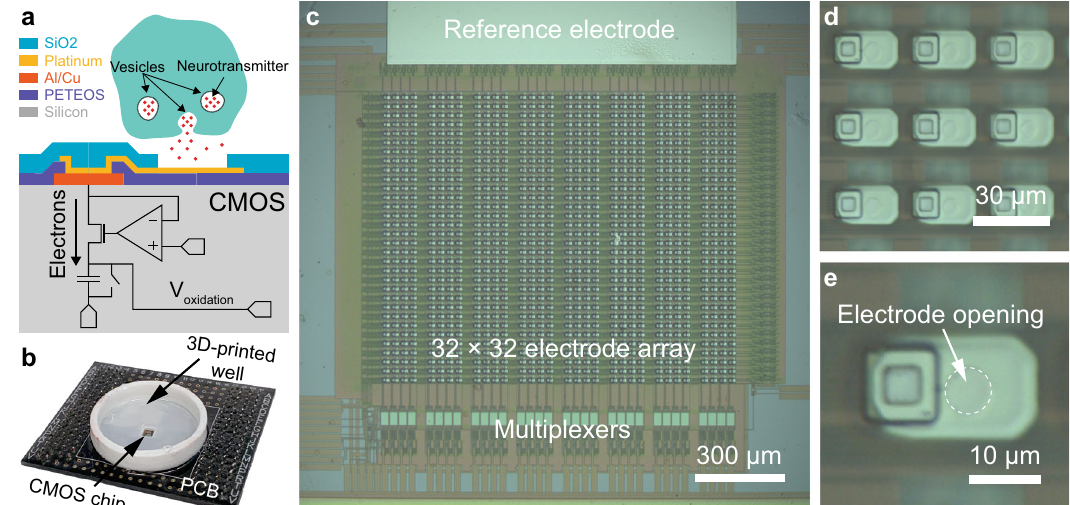
Fig. 1 CMOS-based electrochemical detector array for high-throughput quantal analysis. a Neurotransmitters released from cells diffuse onto an electrode and undergo a redox reaction. The oxidation releases electrons into the electrode and results in electrical current at the ampli fi er, which allows a buildup of electrons onto one side of a capacitor, creating a current-dependent output, V oxidation . The output of the ampli fi er is readout periodically and the capacitor is reset using a switch to begin the next detection period. b The device is bonded onto a PCB to interface the CMOS device to external electronics. The fi nal packaging of the device includes a well that permits the addition of electrolytic solutions to the top of the electrode array for electrochemical experiments. c The CMOS-based electrochemical device contains an array of 32 × 32 electrode array wherein each electrode is connected to its own dedicated ampli fi er and a reference electrode is integrated on-chip next to the electrode array. To readout the 1024 parallel electrochemical detections of secreted neurotransmitters, each column is connected to a dedicated multiplexer. The multiplexers stagger the readout time for the ampli fi ers in its dedicated column, permitting the other 31 ampli fi ers to operate without dead time. d A microphotograph of the 23 µ m × 13 µ m electrodes (white- colored rectangle) patterned throughout the array. e The oxide insulation layer is etched to provide an opening of ~5 µ m above the platinum electrodes, providing an effective electrode area of 5 µ m, which is comparable to the diameter of carbon fi bers used for traditional single-cell electrophysiology oxide passivation layer that are ~5 µm in diameter as shown in Fig. 1e. To remove the remaining NR7 photoresist and clean the surface of the array, the device is put into a piranha solution (3:1 mixture of sulfuric acid:hydrogen peroxide). The resulting effective area of the electrodes throughout the array is comparable to the gold standard CFEs with diameters of ~5 µm 27,33 – 36 .